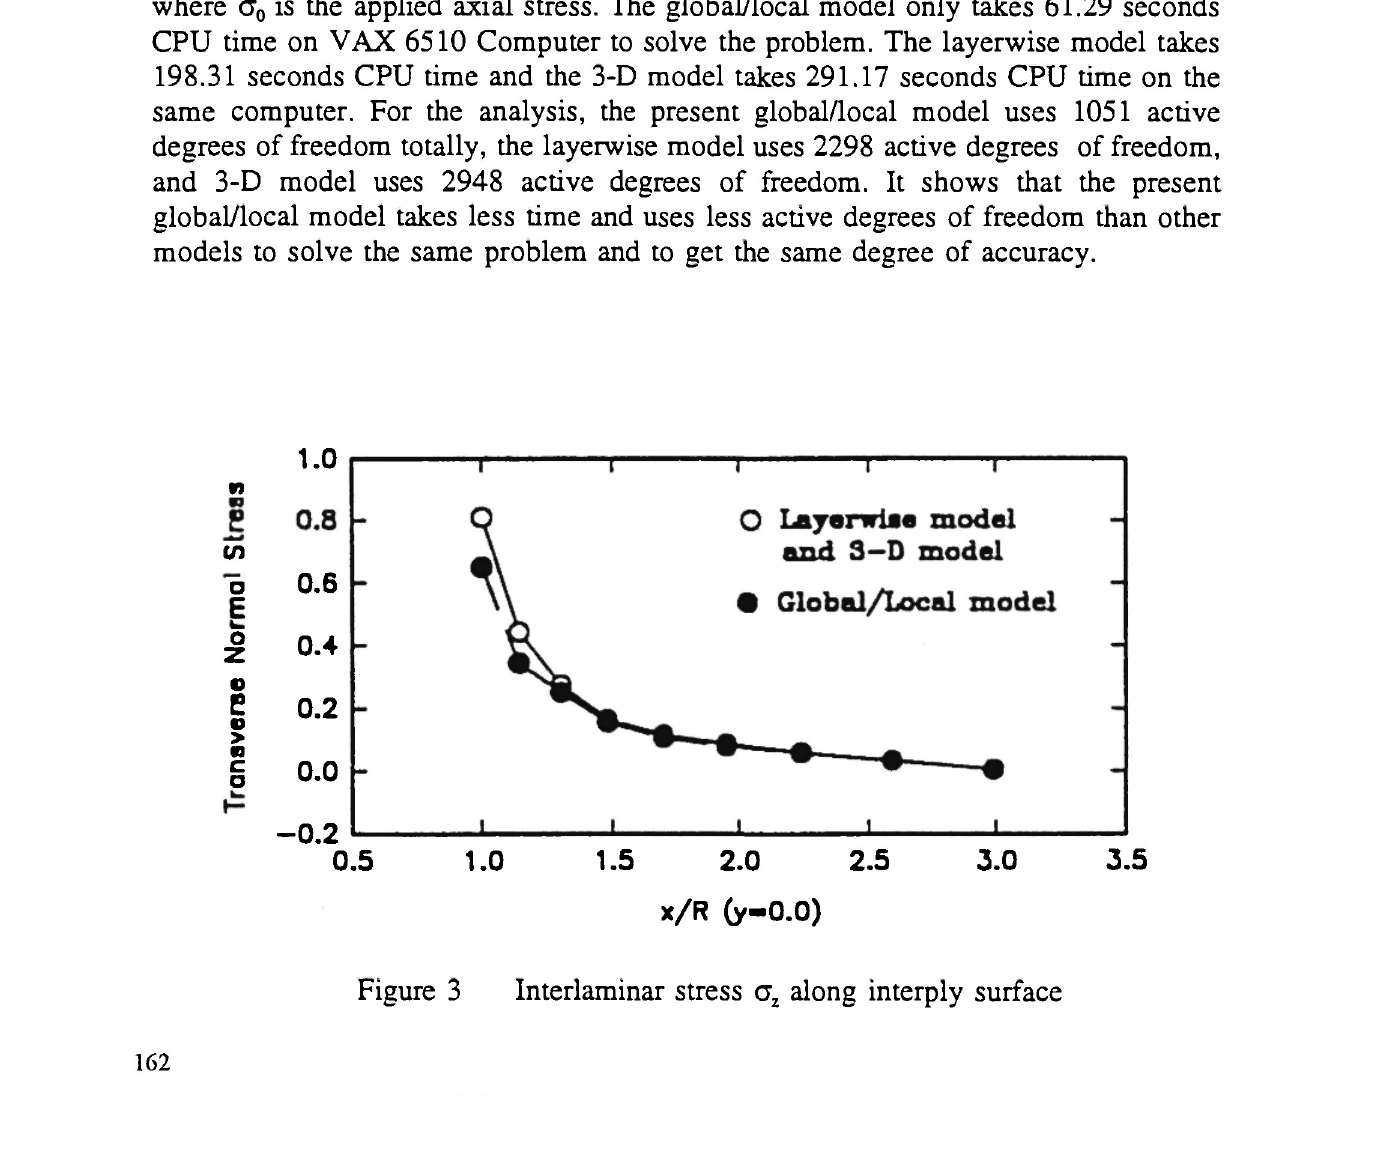
Figure 3 Interlaminar stress σ